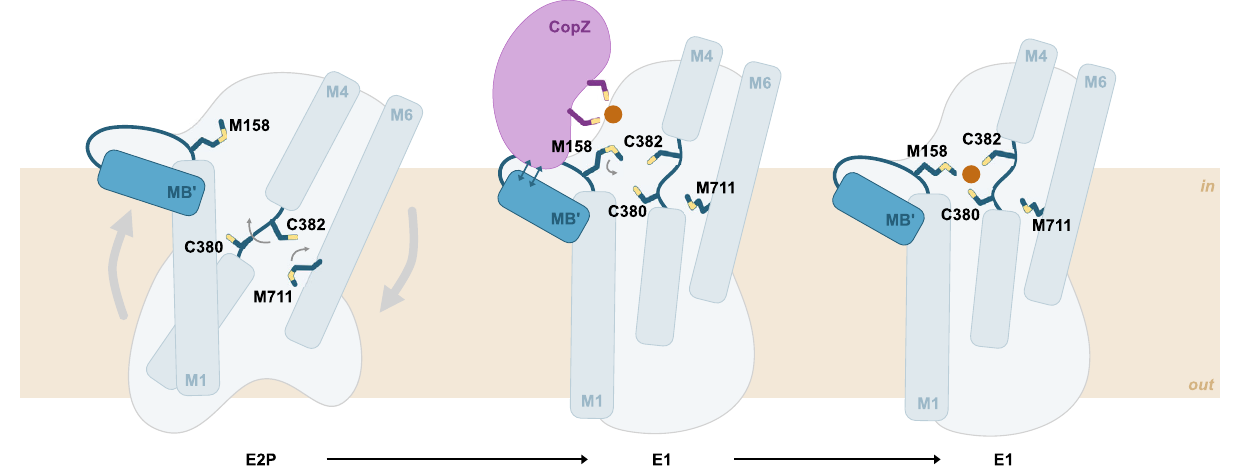
Fig. 5 | Proposed ion uptake mechanism copper transporting P-type ATPases. In the E2P state, the conserved CPC motif in M4 is exposed to the extracellular space. The transition to the inward-open E1 conformation occurs through move- ments of MA-M2 relative to M3-M6. Guided by electrostatic interactions, the cytosolic chaperone CopZ docks to the MB ’ platform. Cu + is then handed over